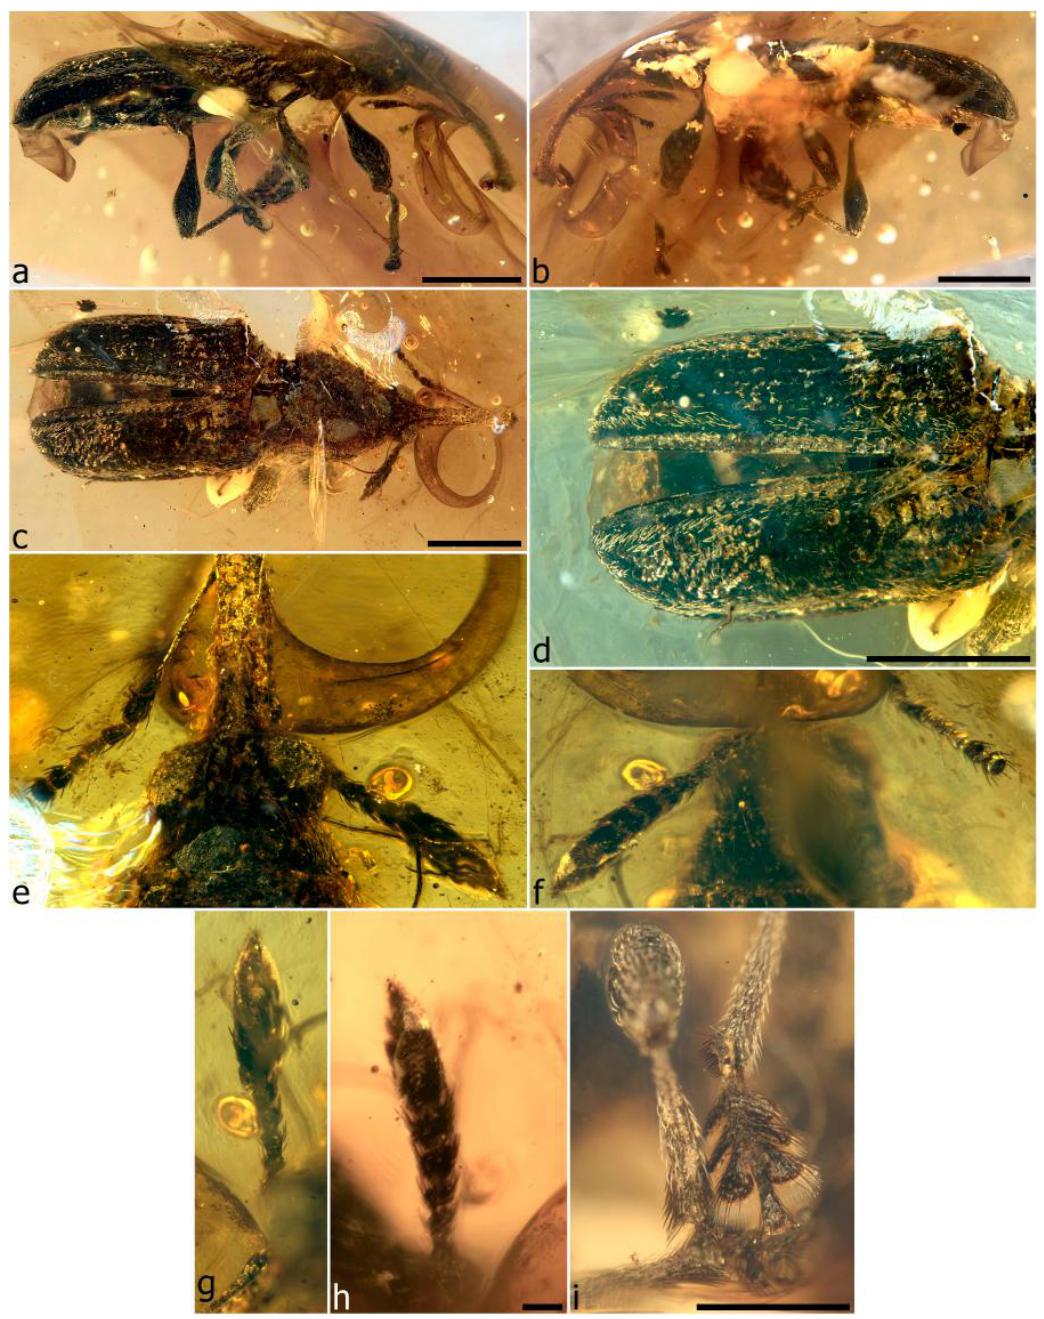
Figure 38. Petalotarsus curculionoides sp. n., holotype. Habitus, right lateral ( a ); habitus, left lateral ( b ); habitus, dorsal ( c ); elytra, dorsal ( d ); head, dorsal ( e ); antennae, ventral ( f ); right antenna ( g ); right antennal club detail ( h ); protarsus ( i ). Scale bars: 1.0 mm (a–d); 0.5 mm (i); 0.1 mm (h).